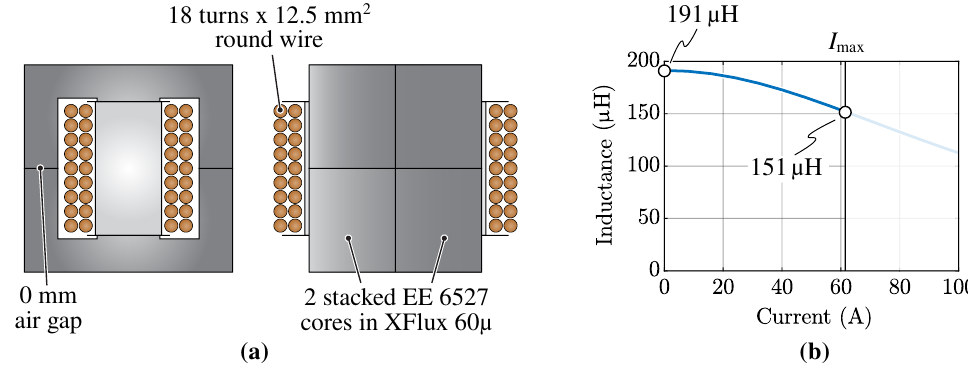
Figure 12. Schematic representation of the designed inductor ( L = L f ) ( a ) and differential inductance value dependence on the DC-bias current ( b ), which highlights the soft saturation characteristic of the selected powder core